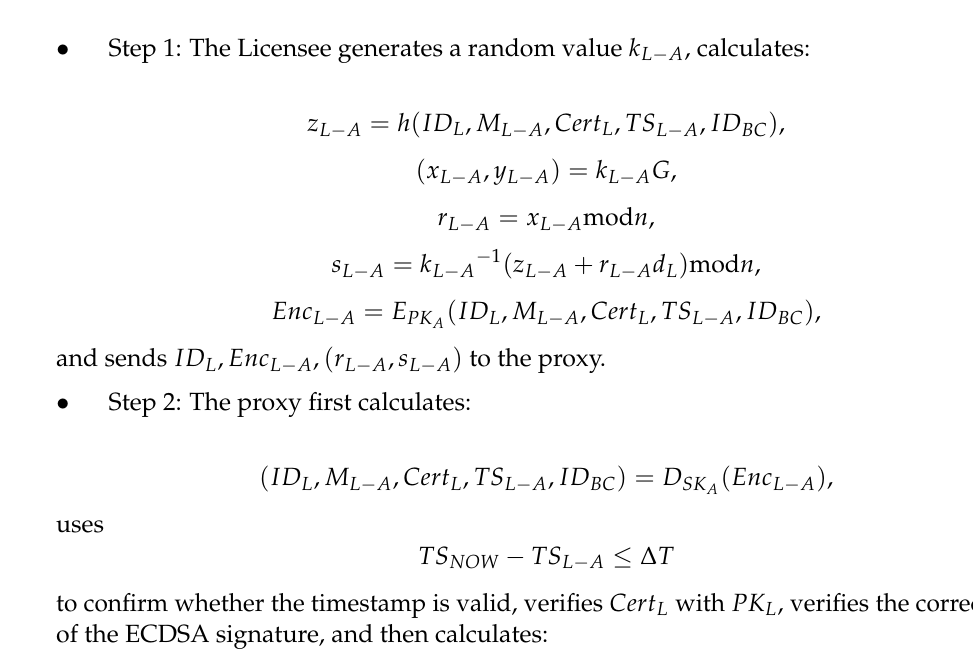
Figure 10. Authentication and issuing invoice phase (P to L).